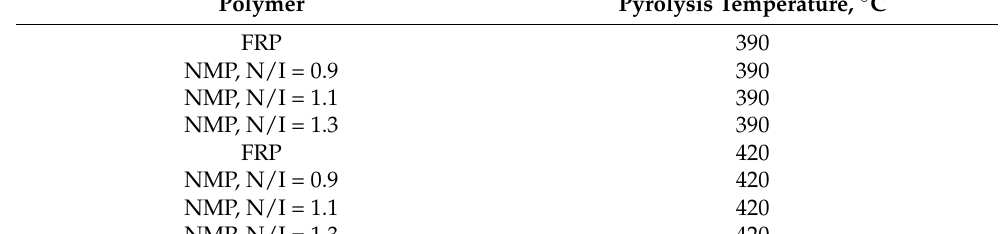
Table 2. Experimental design used in the pyrolysis experiments. All the experiments were run in triplicate.